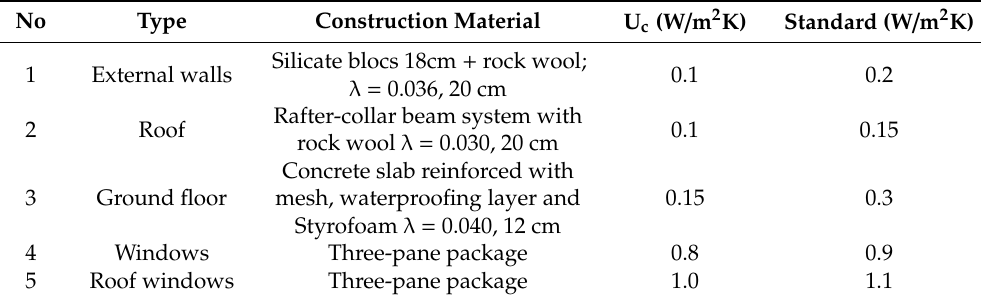
Table 2. Heat transfer coefficient U c of the main building elements .